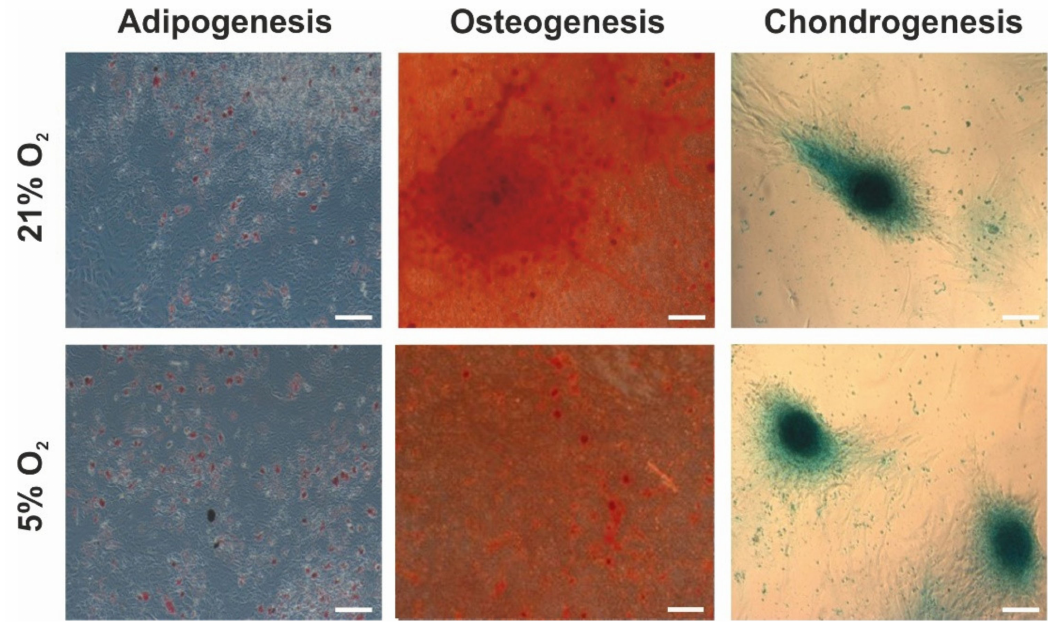
Figure 4. Multilineage differentiation potential of hWJ-MSCs cultured under 21% O 2 and 5% O 2 (passage 3). Phase contrast images of adipogenesis, osteogenesis, and chondrogenesis for WJ-MSC (1) donors are presented as representative (scale bars: 100 µ